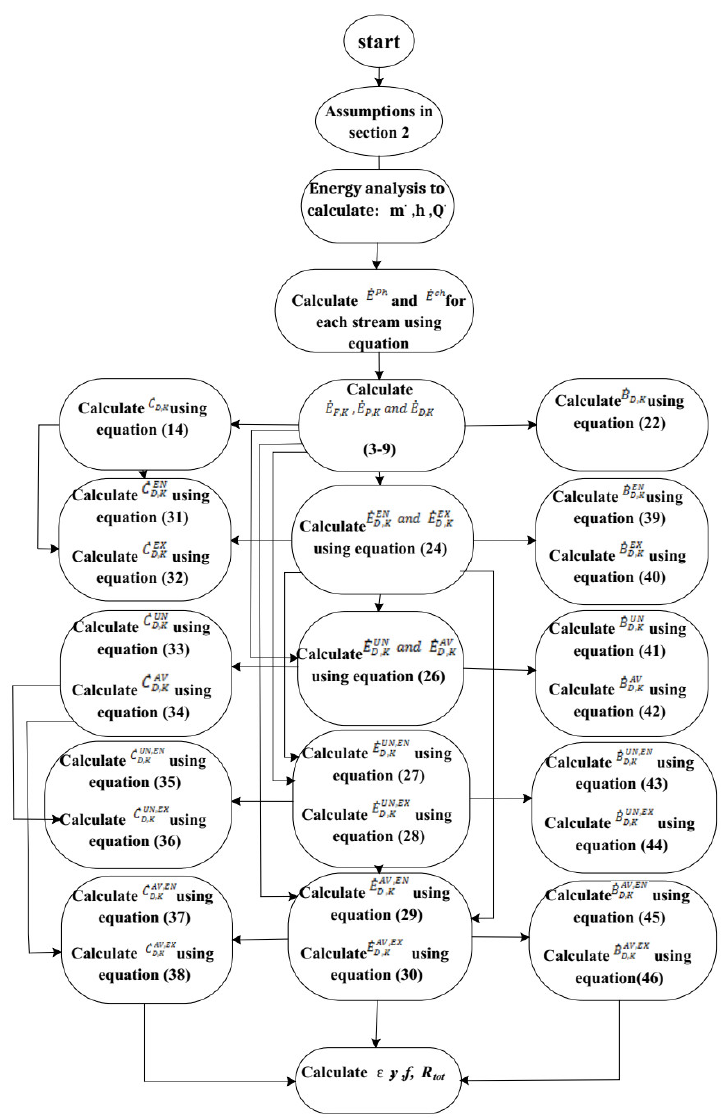
Figure 2. The flowchart of modeling equations of system by Yu et al. [38].